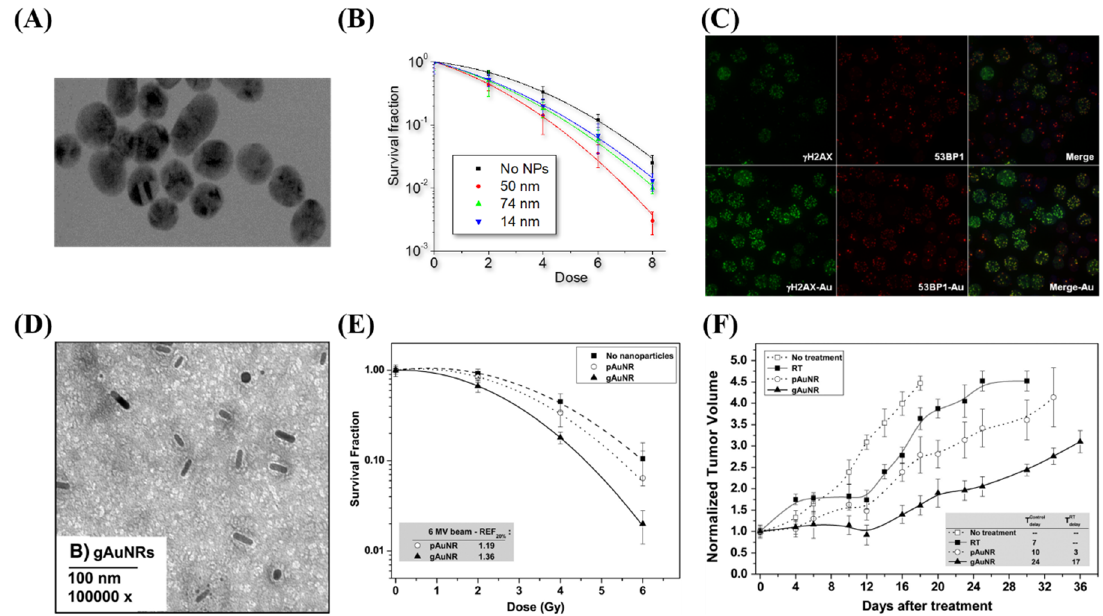
Figure 5. Radiosensitization due to gold nanoparticles. ( A – C ) Spheroidal GNPs improve radiosensitization in vitro, with the largest effect occurring with 50 nm GNPs, as they have the optimum uptake. This can be seen both through clonogenic assays as well as through imaging of double strand break foci with confocal microscopy. ( D – F ) GNRs displayed increased radiosensitization when targeted towards prostate cancer cell lines both in vitro through a clonogenic assay as well as in vivo through tumor volume measurements in a mouse model. Reprinted (adapted) with permission from [117]. Copyright 2015 Elsevier.